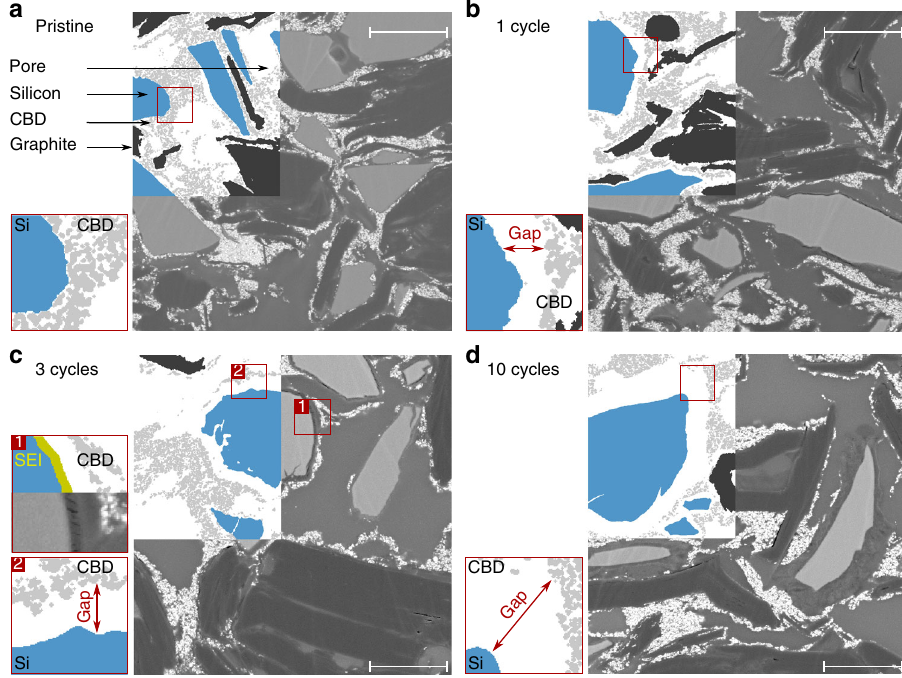
Fig. 3 Scanning electron microscopy. Cross-sectional backscatter scanning electron microscopy images of epoxy in fi ltrated electrodes in combination with the corresponding multi-phase segmentation for a a pristine electrode and fully delithiated electrodes after b one cycle, c three cycles, and d ten cycles. The red boxes show magni fi cations at silicon particle surfaces, highlighting the formation and growth of the gap between the silicon particles and the carbon black-binder domain (CBD). The additional inset in c shows that the space between the silicon particles and the carbon black-binder domain is not completely fi lled with epoxy. Instead, the weakly backscattering dark layer in the vicinity of the silicon particle points to the formation of a thick solid electrolyte interphase (SEI) layer. Scale bars: 5 μ